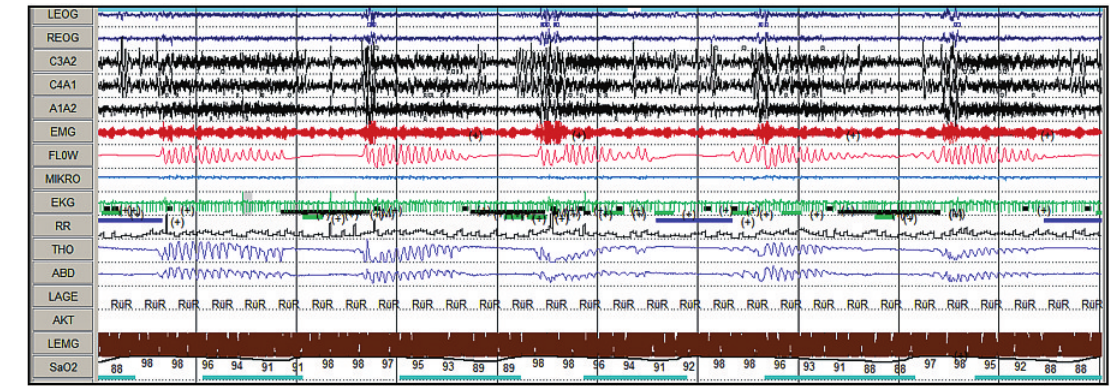
Cheyne-Stokes respiration. The figure presents a 5-min-period of a polysomnography with Cheyne-Stokes respiration.The flow and effort (THO = thorax, BD = ab- domen) channel show the typical pat- tern of waxing and waning amplitude. The arousals (in- creases of amplitude in the EEG channels (C3A2, C4A1) are found at the peak flow amplitude in most events.The res- piratory disturbances are accompanied by decreases of oxygen saturation (SaO 2